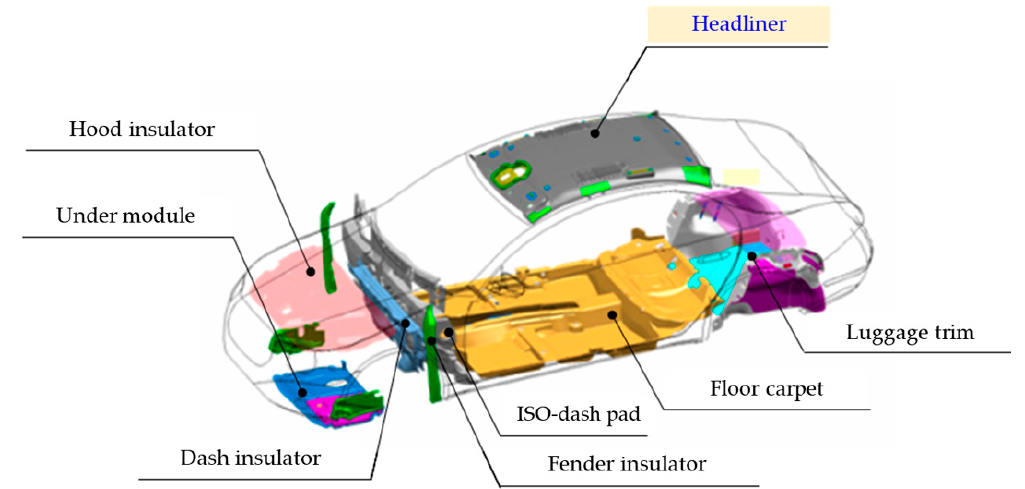
Figure 1. Material configuration of electric vehicle interior.